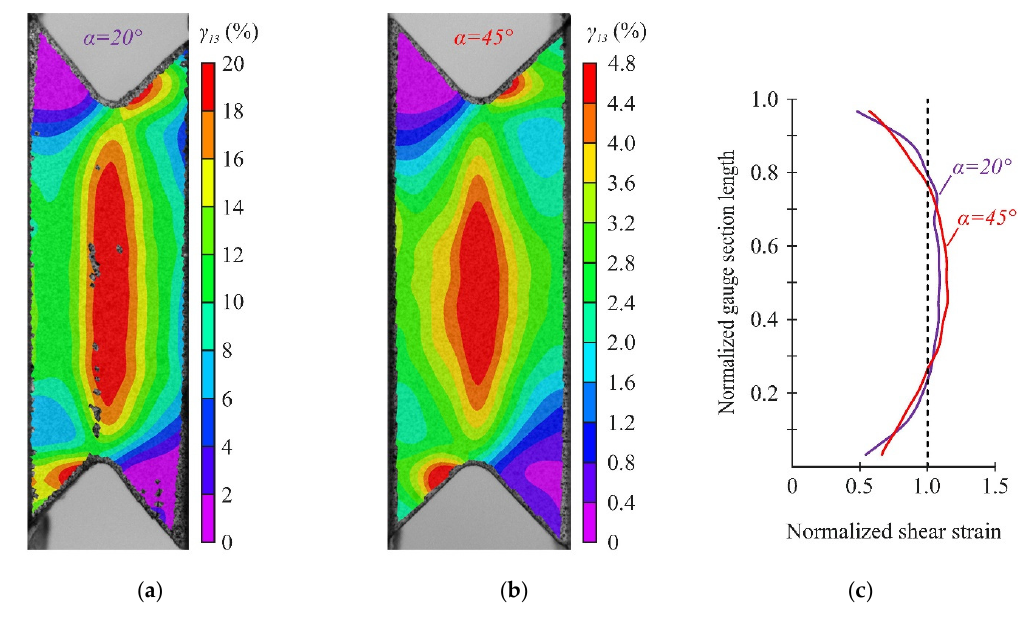
Figure 12. Distribution of through-thickness strains at α = 20°: ( a ) on the face surface of the specimen